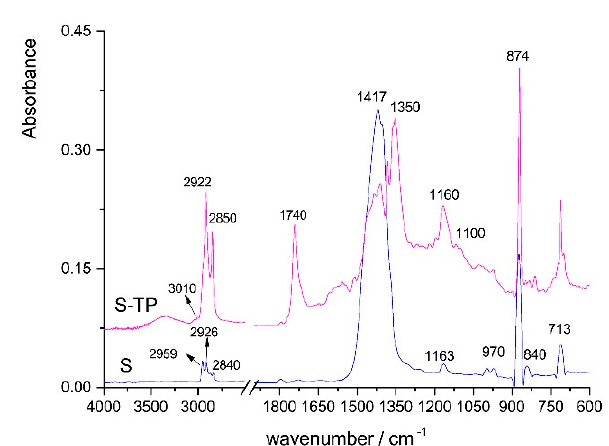
Figure 7. FTIR spectra of synthetic paper (S) and thermochromic print on synthetic paper (S-TP).